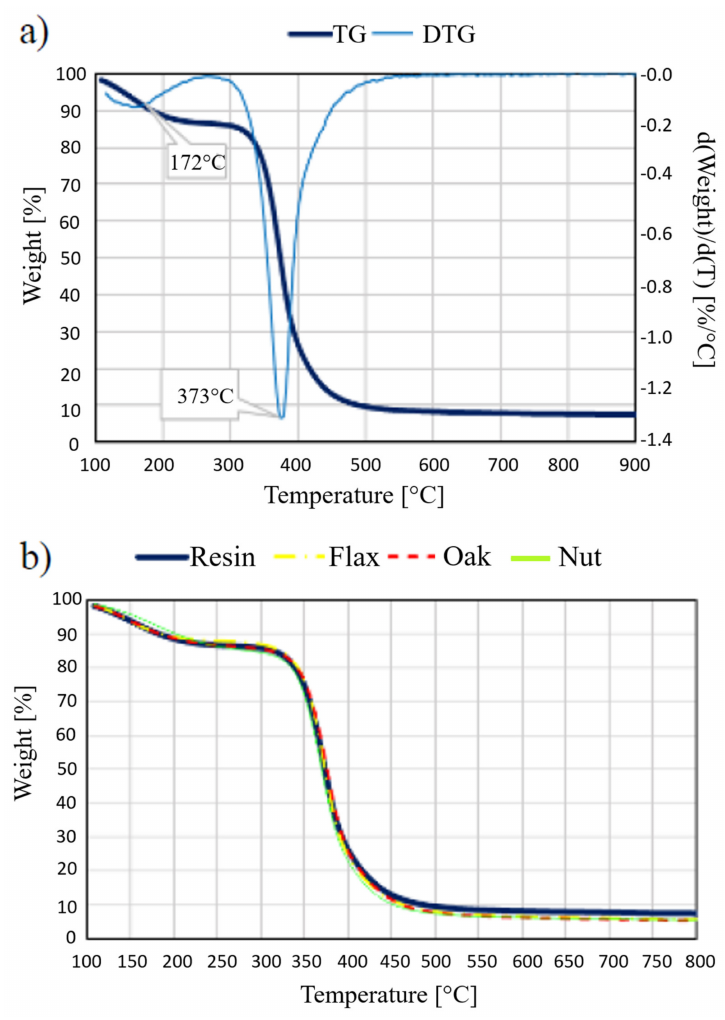
Figure 19. TG and DTG curves for pure resin ( a ), TG curve for resin and composite samples ( b